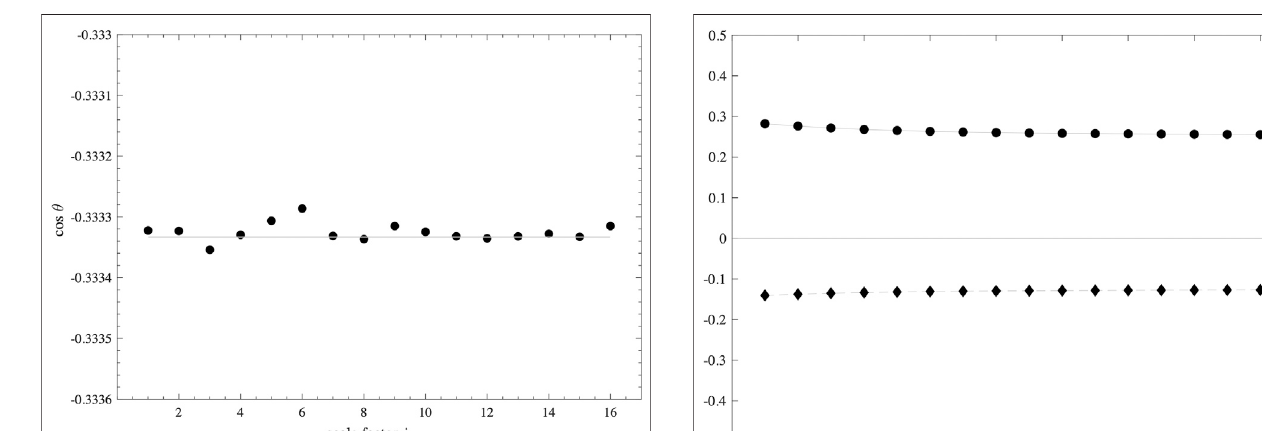
value, hence are not suppressed in the large-scale regime. The 3-metric that comes out from the quantum state correlate different spatial patches of the primordial universe, as required for solving the horizon problem of standard cosmology. It would be interesting to verify that in fi ner